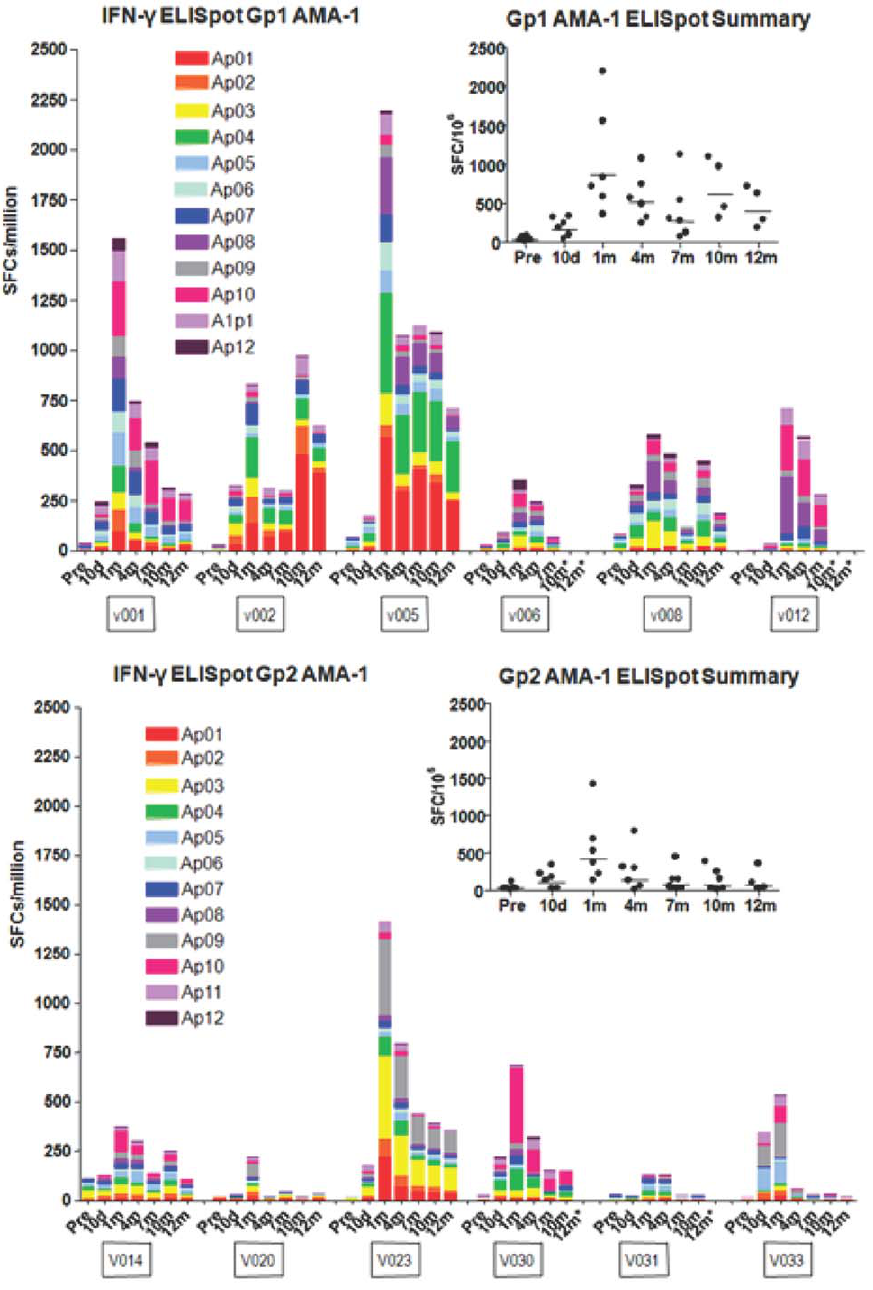
Figure 6. ELISpot activity of serial bleeds of volunteers in Group 1 and Group 2 with AMA1 peptide pools. The ELISpot activities of each volunteer at pre-immunization, 10 d and 1, 4, 7, 10 and 11–12 m are displayed using color-coded AMA1 peptide pools Ap1–Ap12. The inserts show the values of the sum of each volunteer’s responses at each time point and the bar indicates the geometric mean of the group. At 1 month, geomean values were higher (862 sfc/m PBMC’s) in the low dose Group 1 than the high dose Group 2 (422 sfc/m PBMC’s).